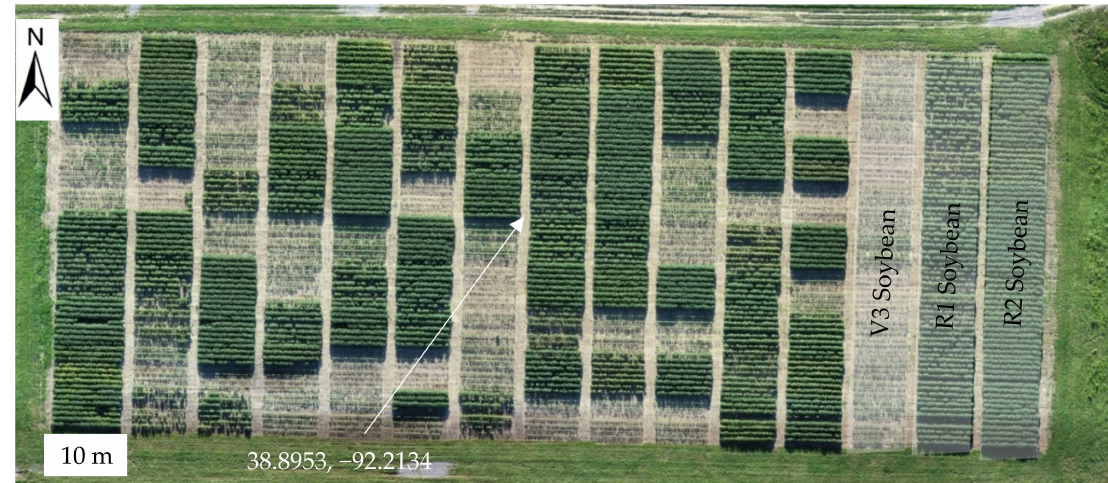
Figure 2. Overhead view of experiment layout. Planting timings and herbicide treatments were arranged in a randomized complete block design with the first rep non-randomized as shown in the image. Subsequent replications were randomized as pictured. Planting randomization occurred with picking up and setting down the planting equipment in appropriate